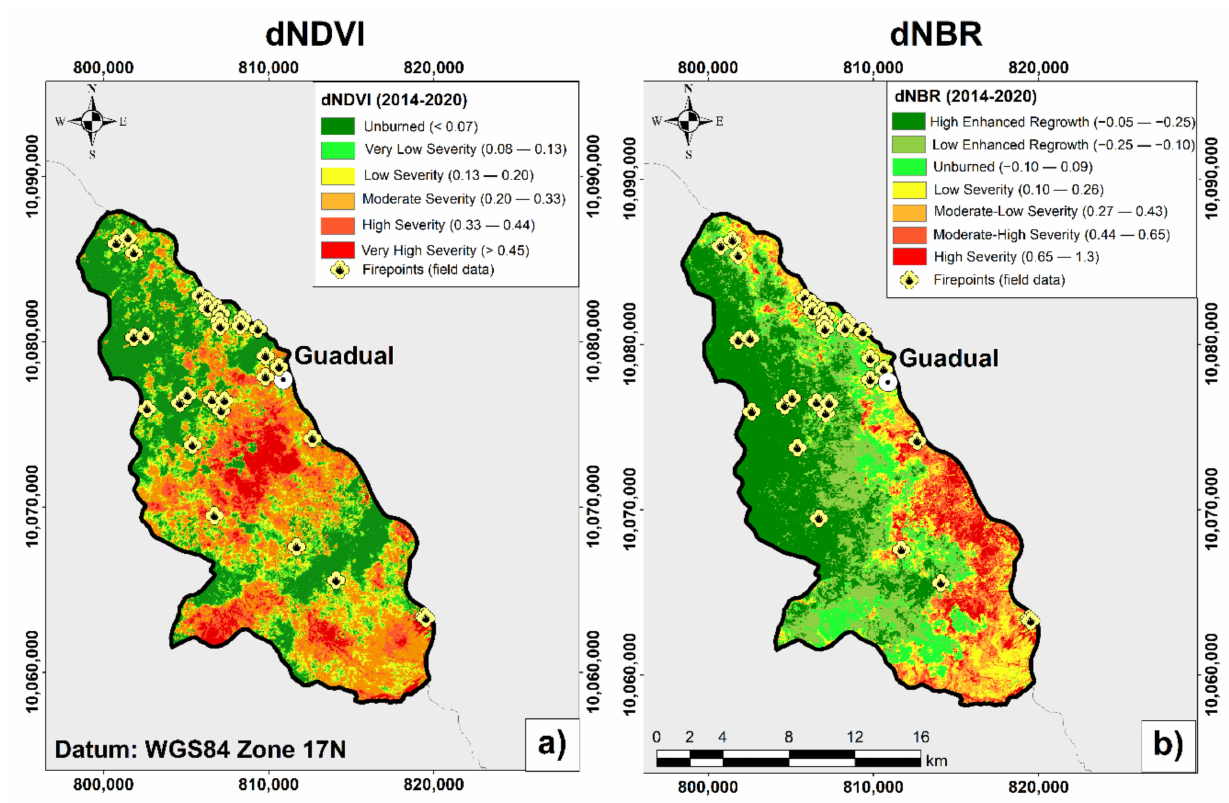
Figure 10. Degree of severity estimated with Landsat-8 images. ( a ) dNDVI between pre-fire 2014 and post-fire 2020 images and ( b ) dNBR between pre-fire 2014 and post-fire 2020